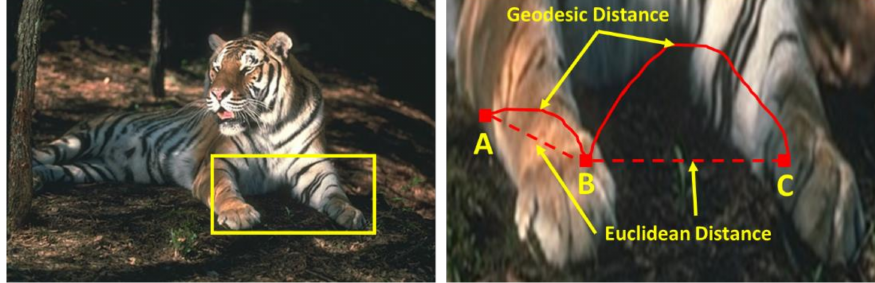
Figure 1. Irrelevance of Euclidean distance measure for super-pixel creation relating to image